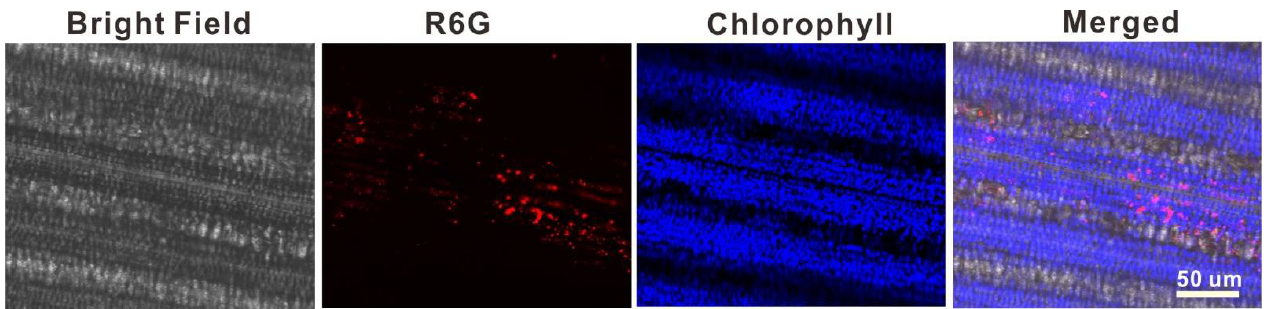
Figure 3. Confocal fluorescence images of DSPE-EB on the surface of maize foliage after washing with 10 mL deionized water (chlorophyll, λ ex : 630 nm, λ em : 670 nm, R6G, λ ex : 555 nm, and λ em : 580 nm).